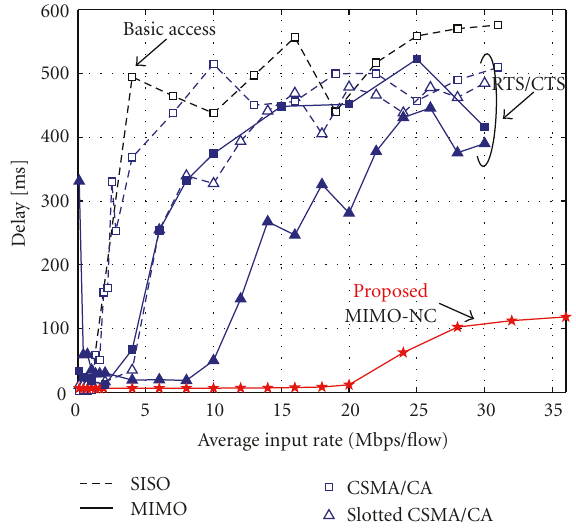
Figure 15: Average packet delay performance comparison of CSMA/CA and MIMO network